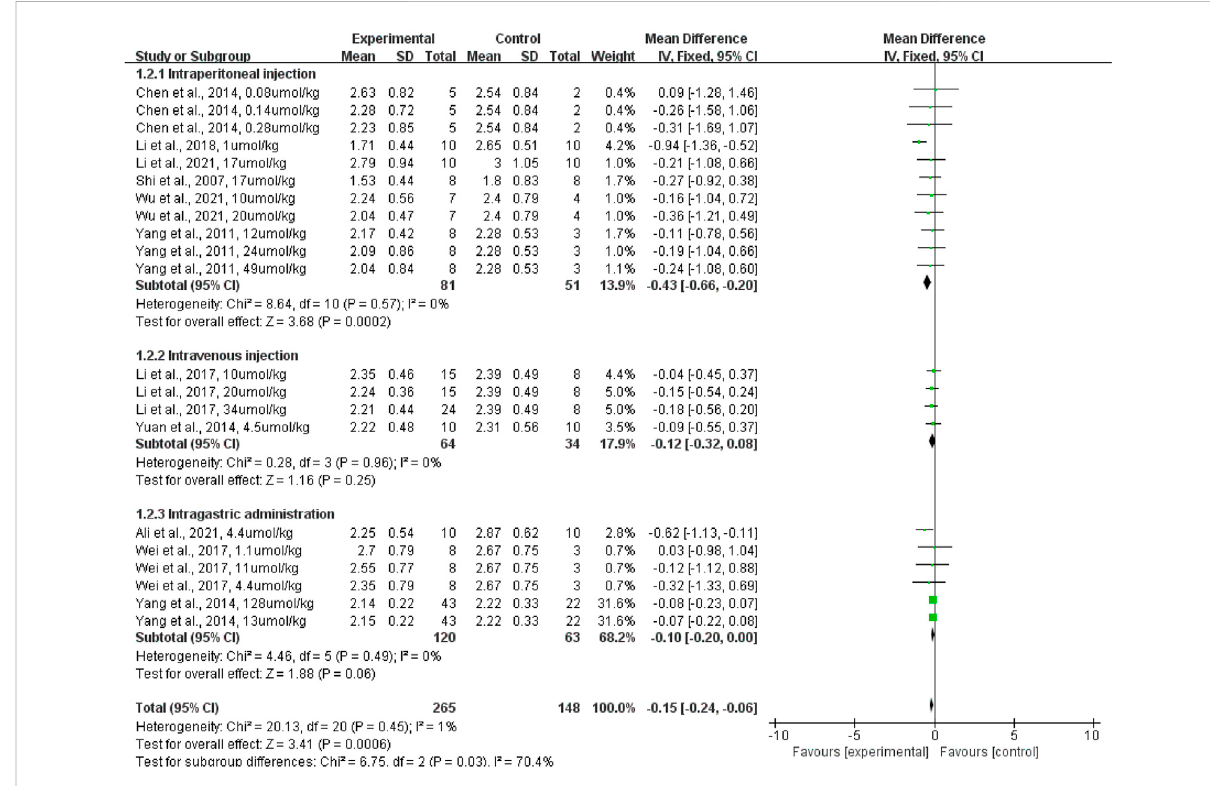
FIGURE 5 The forest plot of therapeutic ef fi ciency of therouteof terpenoid administration on lung wet-to-dry weightratio. Subgroup analyses evaluated the therapeutic ef fi ciency of intraperitoneal injection, intravenous injection, and intragastric administration. CI, con fi dence interval; IV, inverse variance; Std, standard; SD, standard